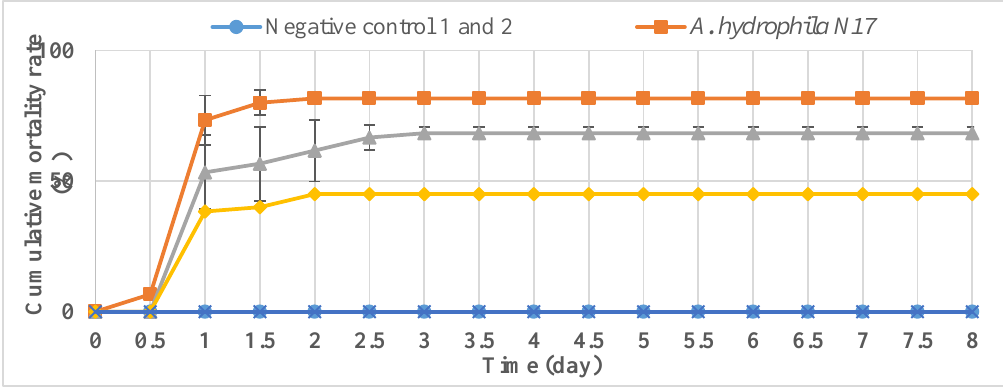
Figure 5. Cumulative mortality rates (%) of striped catfishes obtained in challenging experiments using A. hydrophia N17 and the phage cocktail at the different MOIs (0.01, 0.1, and 1). The ratio of Φ2 to Φ5 in a phage cocktail was 1:1.